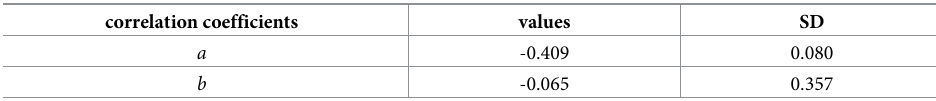
where S is the slope (m m − 1 ), V is the flow velocity (m s − 1 ), D is the runoff depth (m), and k and e are correlation coefficients that are mainly related to the properties of the original soil or sediment particle size distribution. The regression coefficients of the equation are shown in Table 7. According to regression coefficient k , the ER values were negatively correlated with oc the product of slope, flow velocity, and runoff depth. These findings are consistent with the effects of flow velocity, runoff depth, shear stress, stream power, and slope on the OC concen- tration in the sediments. The absolute average calculated errors of the ER values in the sedi- oc ments were below 0.26 (Table 8), and the R 2 values of the equation for the ER values in the oc sediments were 0.789 (Fig 9). Table 7. Regression results of the ERoc calculated equation. correlation coefficients values